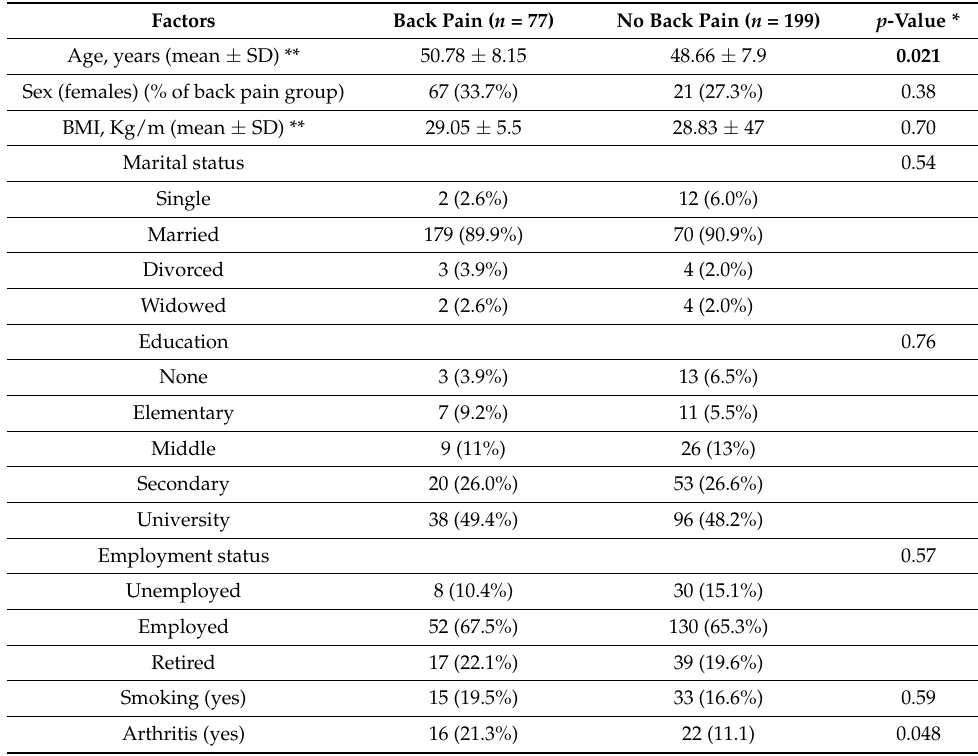
Table 1. Demographics and clinical characteristics for